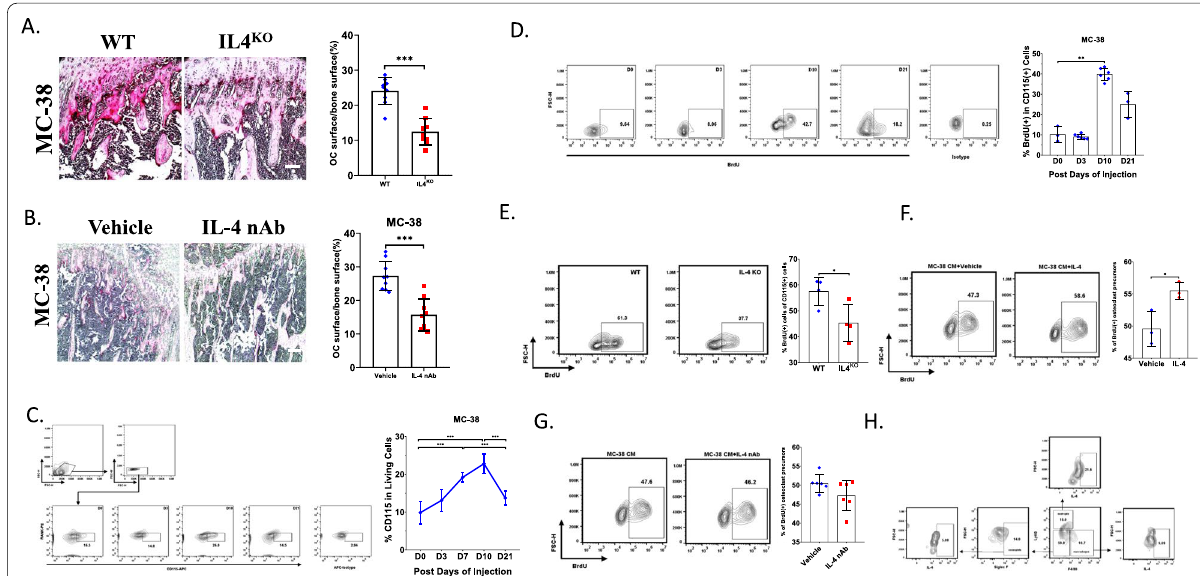
Fig. 2 Neutrophils‑derived IL‑4 stimulates the proliferation of early OCPs. A TRAP staining showed the TRAP( ) cells in trabecular area at D21 + after injection of MC‑38 in WT mice or IL4 KO mice and the quantification of OC area in bone surface (Scale bar 100 μm) (n 9). B TRAP staining = = showed the TRAP( ) cells in trabecular area at D21 after injection of CT‑26 after treatment with vehicle or IL‑4 neutralizing antibody and the + quantification of OC area in bone surface (Scale bar 100 μm) (n 9). C Flow cytometry plots and quantification of the percentage of early OCPs = = at each timepoint after injection of MC‑38 cells into tibias and the quantification (n 3–9 per condition, each sample was pooled from 2 mice). D = Flow cytometry plots and quantification of the percentage of BrdU( ) early OCPs at each timepoint after injection of MC‑38 cells into tibias and + the quantification (n 3–6, each sample was pooled from 2 mice). E Flow cytometry plots and quantification of the percentage of BrdU( ) early = + OCPs in WT mice and IL4 KO mice at 10 days post injection of MC‑38 cells. (n 4, each sample was pooled from 2 mice). F Flow cytometry plots and = quantification of the percentage of BrdU( ) early OCPs cultured in MC‑38 CM after stimulated by vehicle or IL‑4. (n 3) G Flow cytometry plots and + = quantification of the percentage of BrdU( ) early OCPs cultured in MC‑38 CM with or without IL‑4 neutralizing antibody. (n 6) H Flow cytometry + = plots of the percentage of IL‑4 ( ) cells in neutrophils, macrophages or neutrophils, respectively. *p < 0.05, **p < +